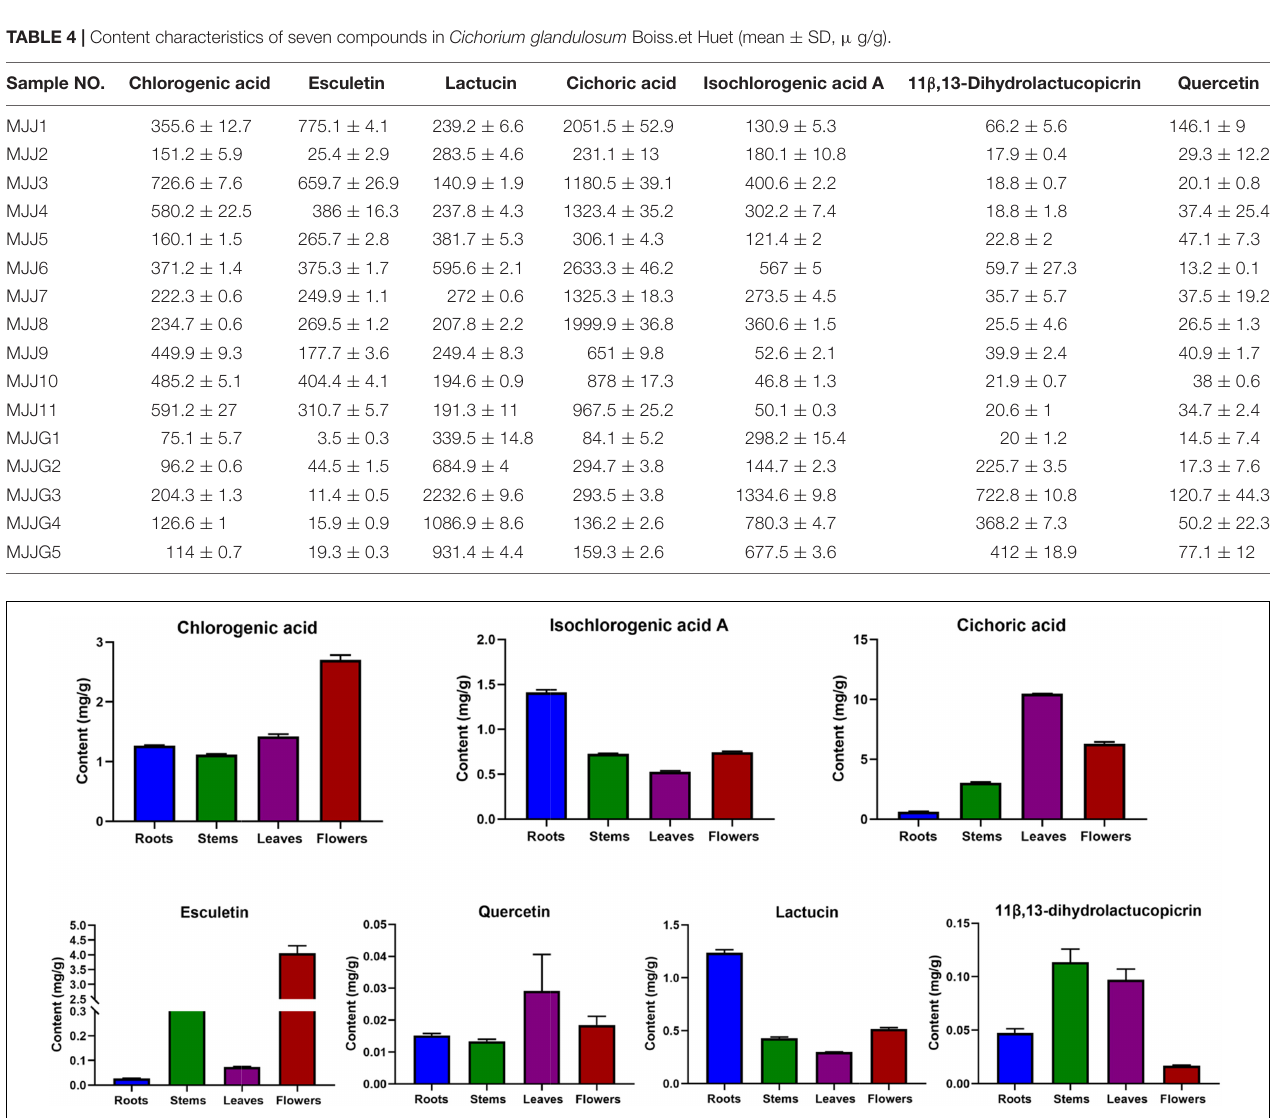
FIGURE 8 | Distribution characteristics of the seven components in the roots, stems, leaves, and flowers of chicory.